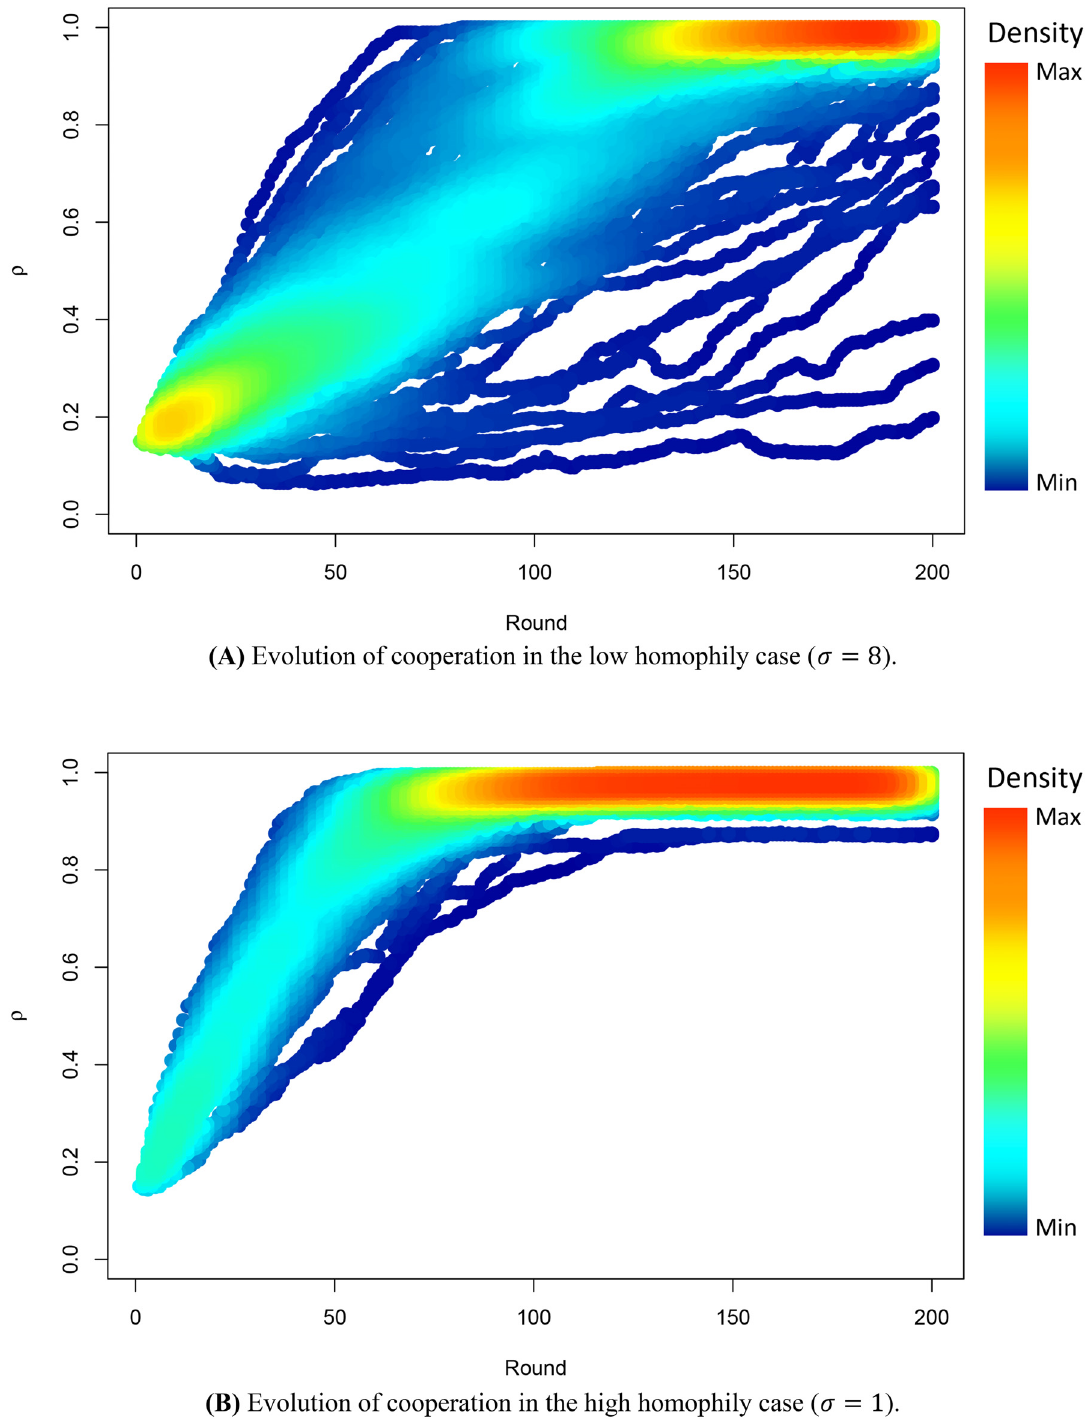
Fig 5. Emergence of cooperation over time. The figure illustrates the fraction of cooperative nodes against the rounds or time steps: low homophily ( A ) and high homophily ( B ). The figure shows the evolutionary dynamics of the PD game played between the interacting nodes in a multiplex network with M = 3 layers. In both cases N = 1000 nodes. The results are obtained choosing a fixed number of simulations and the colour corresponds to the density: ‘ red ’ indicates the highest density (that is the maximum number of overlapping points), while ‘ blue ’ means the lowest density. As can be observed, increasing the homophily value of the multiplex network M , we note a faster emergence of